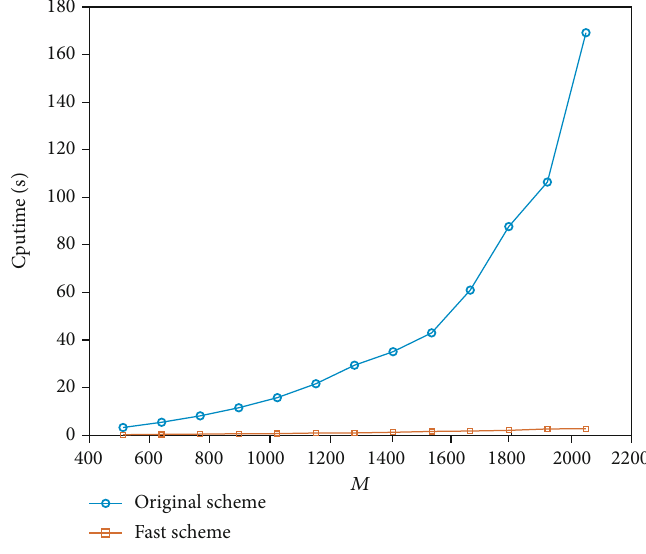
Figure 2: Comparison of CPU execution time between original and fast schemes with fi xed α = 0 : 5 and β = 0 :